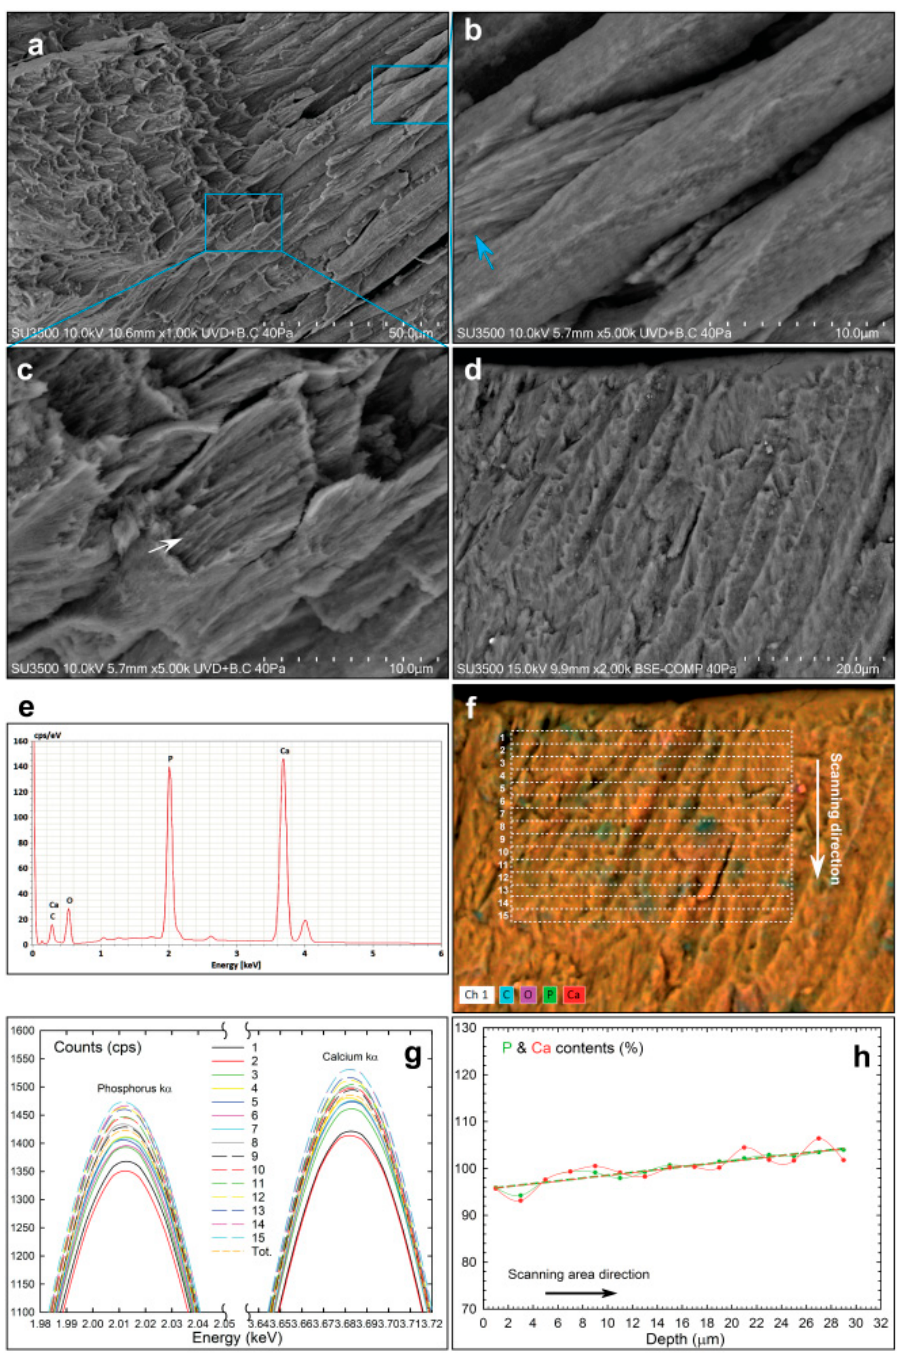
Figure 1. Morpho-chemical study of untreated deciduous enamel tooth. ( a ) VP-SEM image illustrating the inner surface morphology. ( b ) VP-SEM magnification showing crystalline rods wrapped in a sheath of enamel matrix (blue arrow). ( c ) VP-SEM magnification showing aligned fracture rods (white arrow). ( d ) VP-SEM image of cross-sectioned enamel close to the outer surface ( e ) EDS spectrum probed in Figure 1d. ( f ) Elemental mapping image of major constituents overlapped with a cross-pattern denoted by a white dotted line rectangle. ( g ) Plots showing the characteristic peak energy of P-k α and Ca-k α corresponding to each rectangular area of the Figure 1f. ( h ) Experimental plot showing atomic percentage distribution of P and Ca elements along the scanning area direction (dotted line) and data fitted by linear regression (short dashed